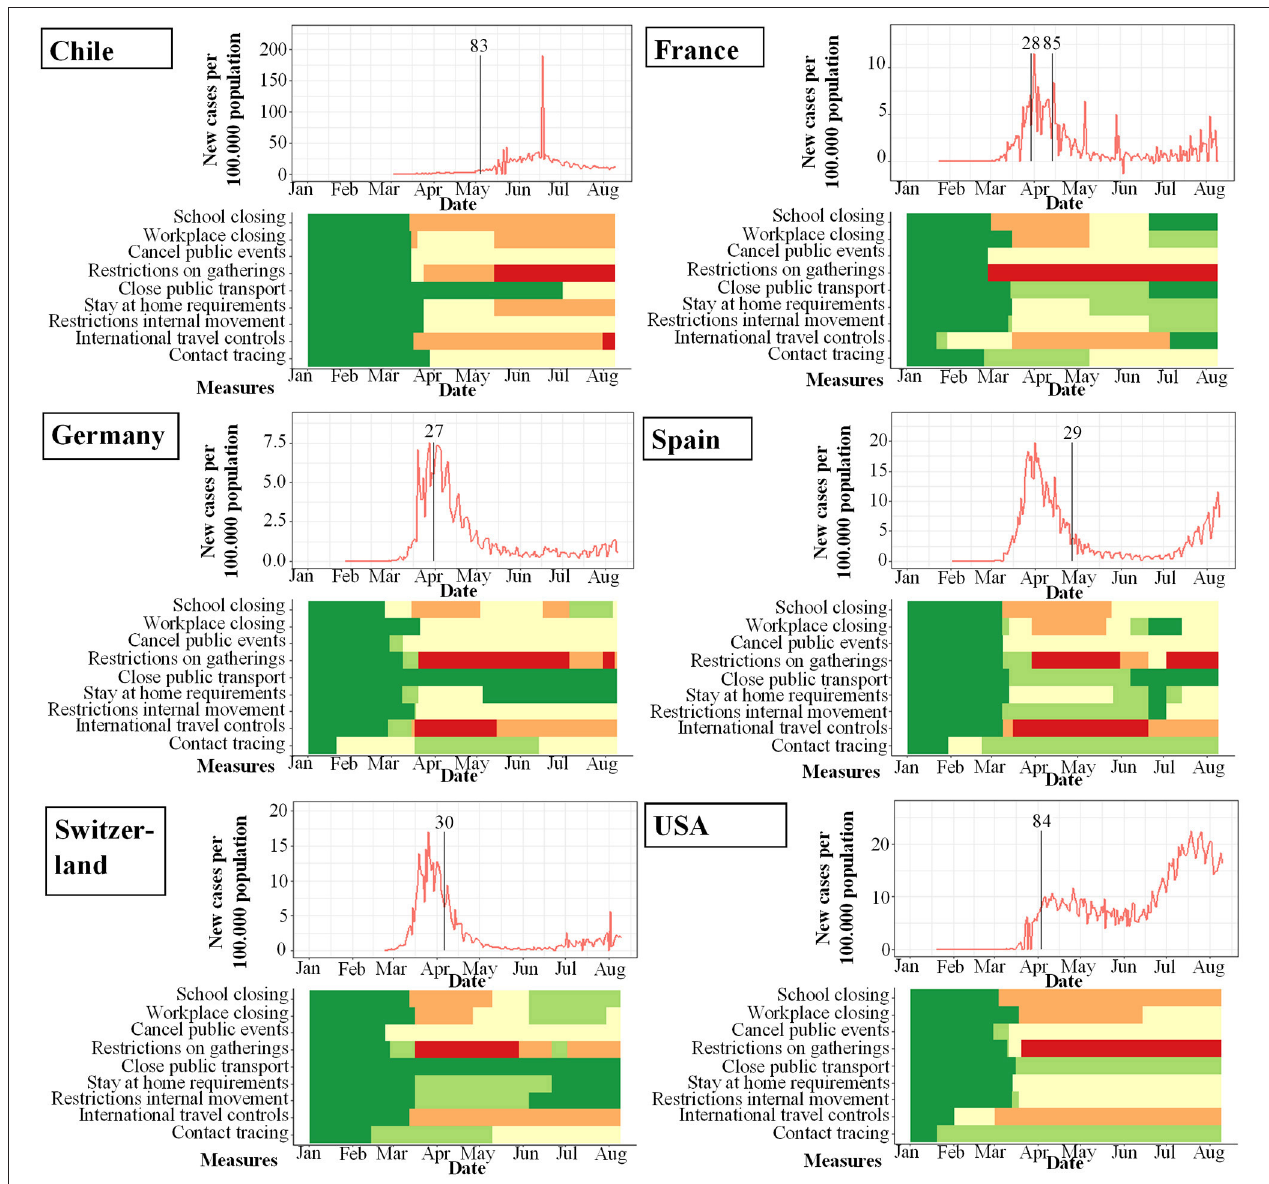
FIGURE 5 | Seroprevalence studies and their start (indicated by vertical bar) in proportion to incidence of new infections with SARS-CoV-2 per 100.000 per day (y-axis) and changes over time (x-axis). Local response reactions to reduce spread of SARS-CoV-2 are shown below the x-axis in colored bars. Green bars mean no restrictions, red fullrestrictions, e.g. shut down of transport, no gatherings. Dataset of the figure is available in the Supplementary Material